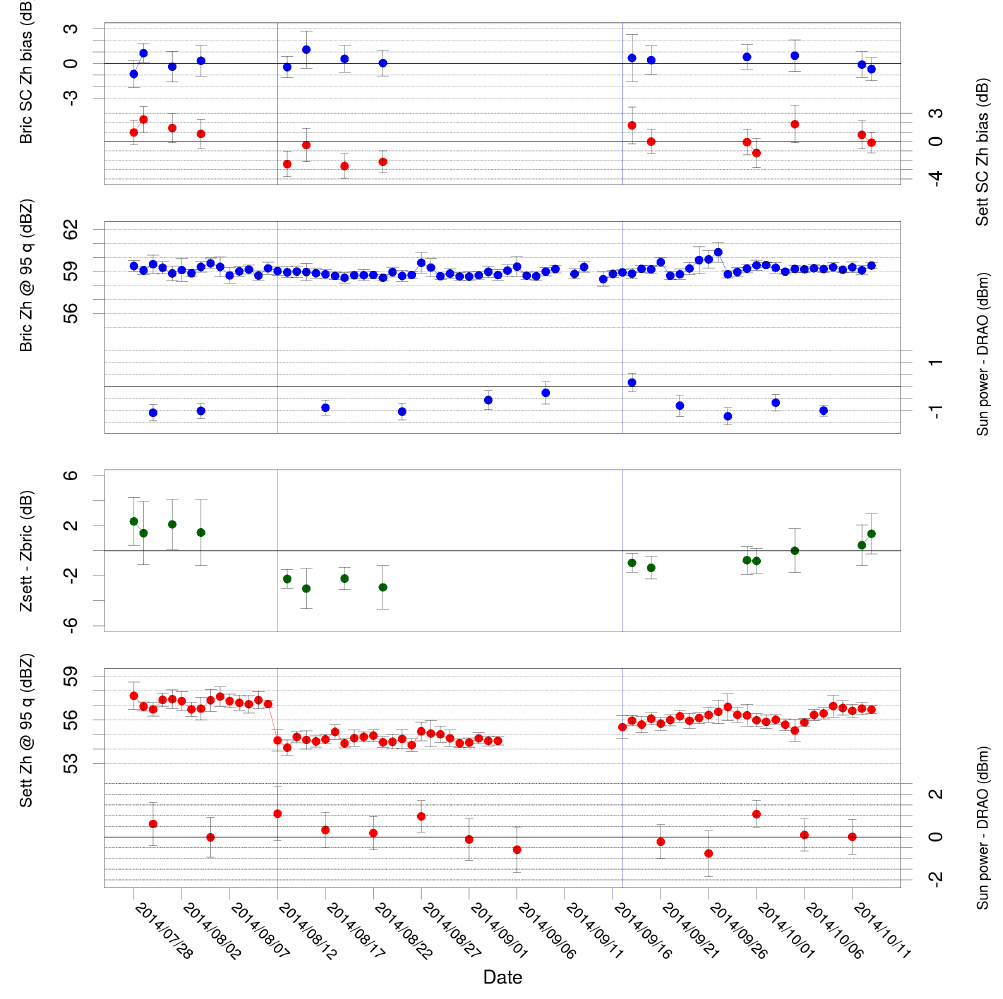
Figure 18. Monitoring the stability of radar calibration. From the top, Bric della Croce (blue) and Monte Settepani (red) self-consistency; Bric della Croce ground clutter and Sun calibrations; Bric della Croce and Monte Settepani intercalibration (green); Monte Settepani ground clutter and Sun calibrations. The error bars represent the estimated uncertainty. In the Sun calibration, the DRAO reference at 20:00UTC, as reported in Wolff et al. (2015), is subtracted from the observed solar power. The vertical blue lines divide the study period in three sectors as reported in the